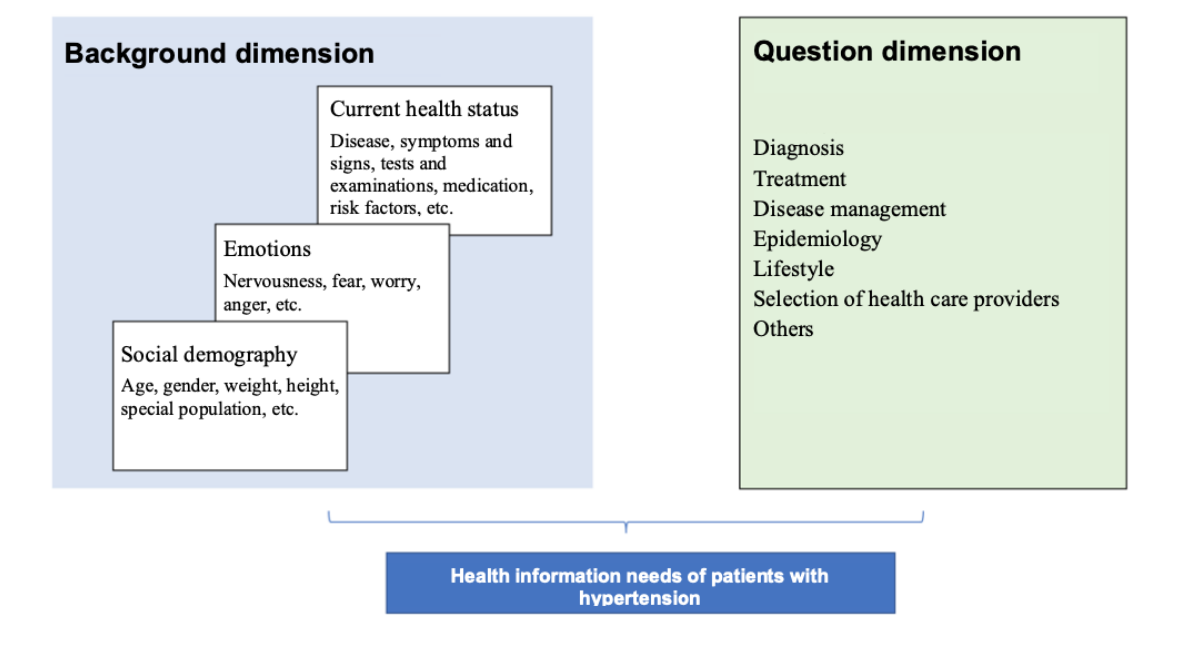
Figure 1. Classification framework diagram for the health information needs of patients with hypertension.